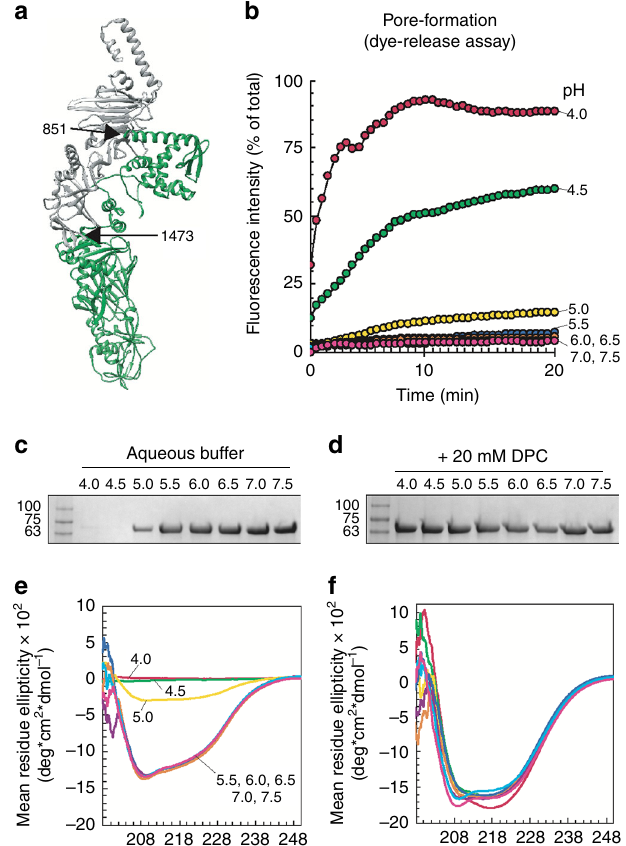
Fig. 7 TcdB 851-1473 is an autonomous protein domain. a TcdA T-domain (pdb: 4R04), with 851 – 1473 colored in green. b TcdB 851 – 1473 induced dye release from HPTS/DPX loaded liposomes from pH 4.0 to pH 7.0 in 0.5 pH increments. c Stability of TcdB 851 – 1473 in aqueous buffer and with d 20 mM DPC from pH 4.0 to pH 7.5 in 0.5 pH increments. e Circular dichroism (CD) spectroscopy of TcdB 851 – 1473 in aqueous buffer and f 20 mM DPC from pH 4.0 to pH 7.5 in 0.5 pH. Coloring for each pH in f is the same as in e . All experiments are N = 3. Source data are provided as a Source Data File for Fig. 7c,